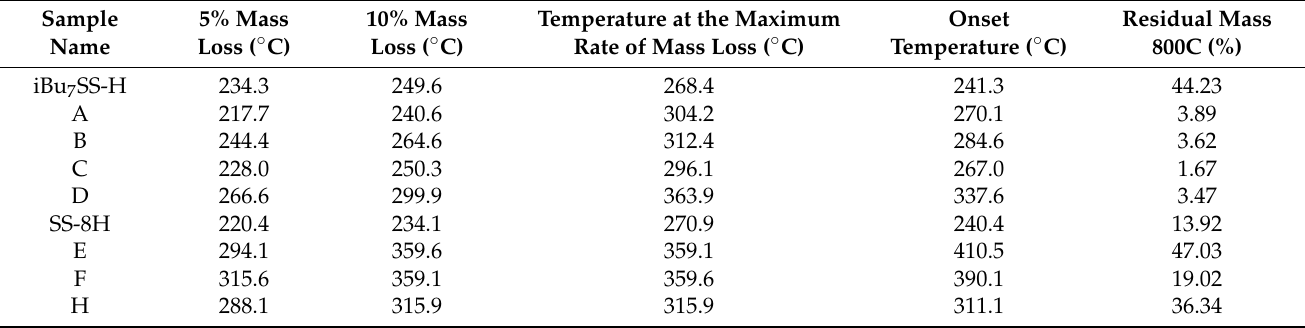
Table 2. Summary of the data from the conducted measurements: the beginning of the decomposition process (onset).